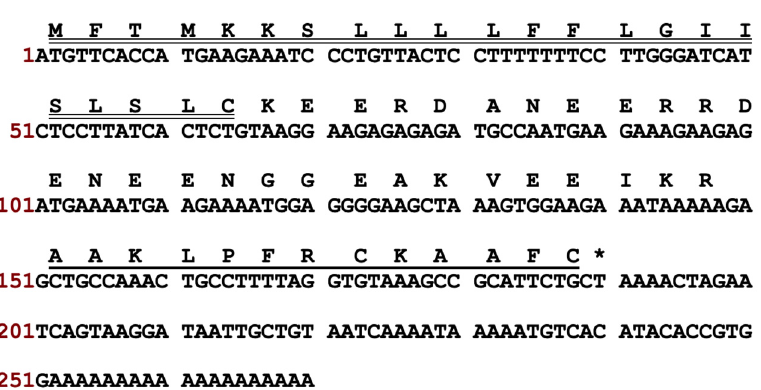
Figure 1. Nucleotide sequence and corresponding translated amino acid sequence of kunitzin-OV 2 precursor cDNA. The putative signal and mature peptides are marked by double and single underlines, respectively. The stop codon is indicated by an asterisk.